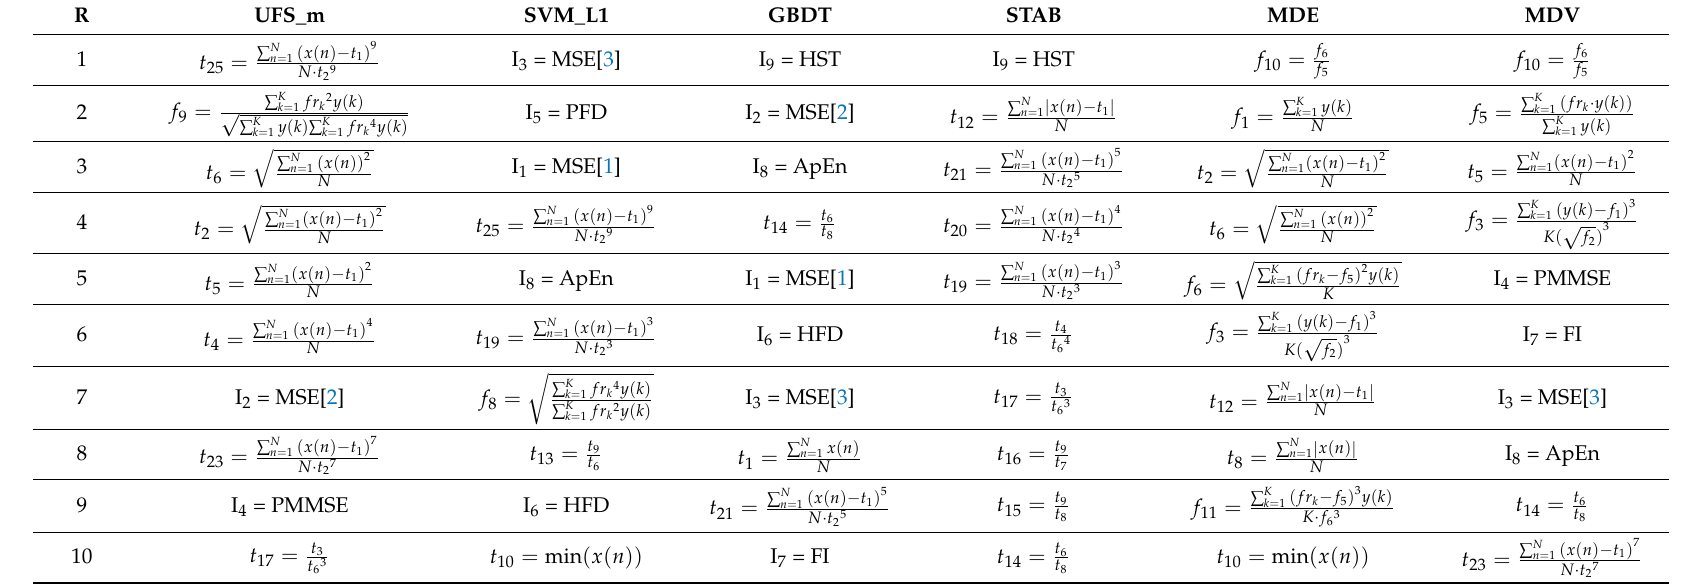
Table A1. Top 10 ranking feature